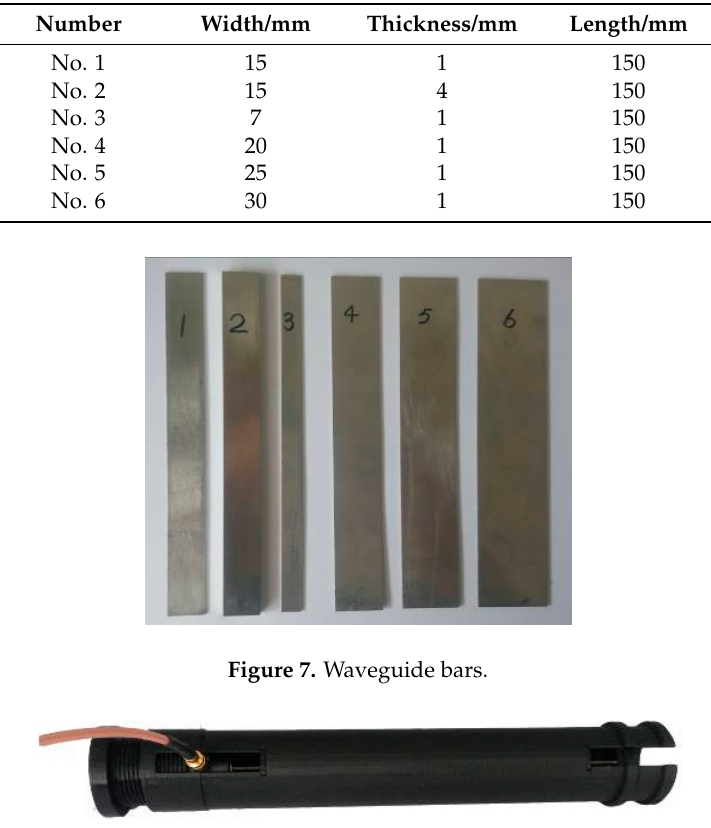
Figure 8. Installation of the waveguide bar and transducer.